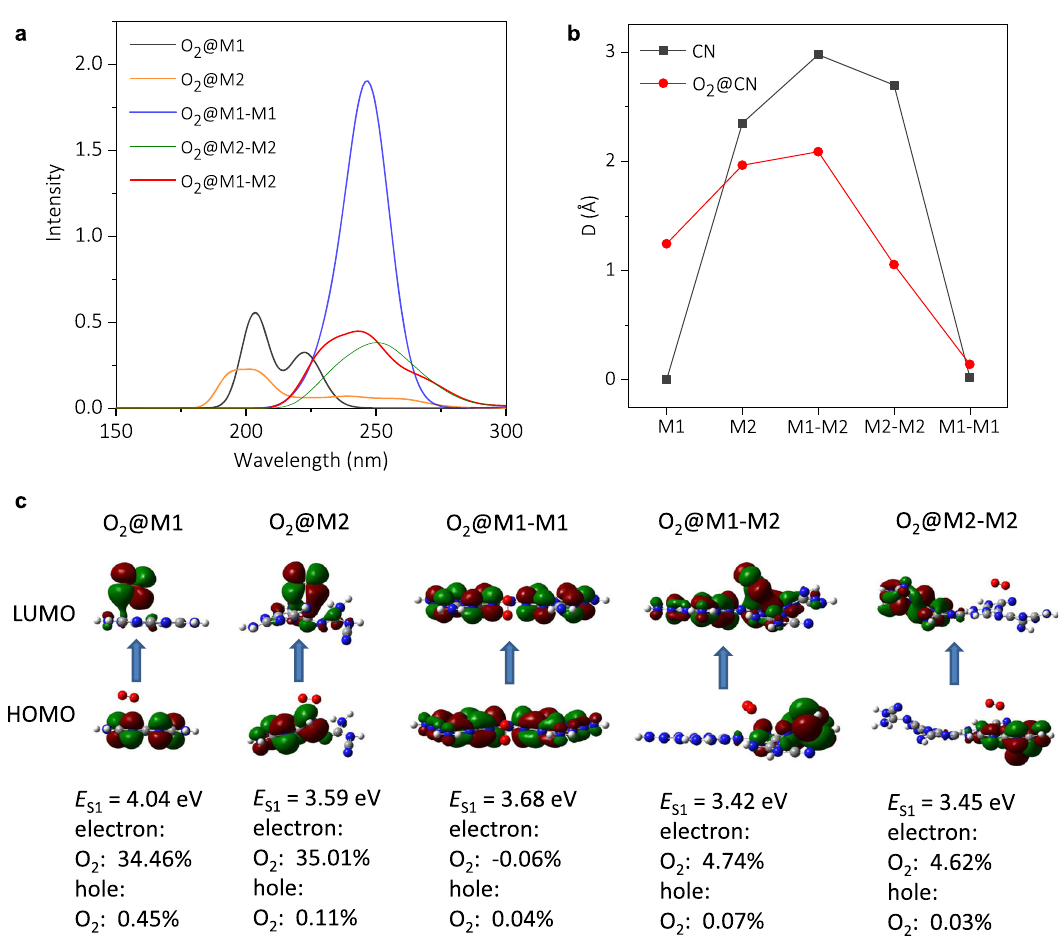
Fig. 3 Computational analysis of M1, M2, and electron coupling. a Simulated absorption spectra of O 2 @CN. b Centroids distance ( D ) of electrons and holes in the lowest singlet electronic excited state (S 1 ) of CN and O 2 @CN. c Isosurface plots of the highest occupied molecular orbital (HOMO) and the lowest unoccupied molecular orbital (LUMO) of different O 2 @CN. The excitation energy ( E S1 ) and the percentage of O 2 contribution to electrons and holes in S 1 are shown in the bottom panel.